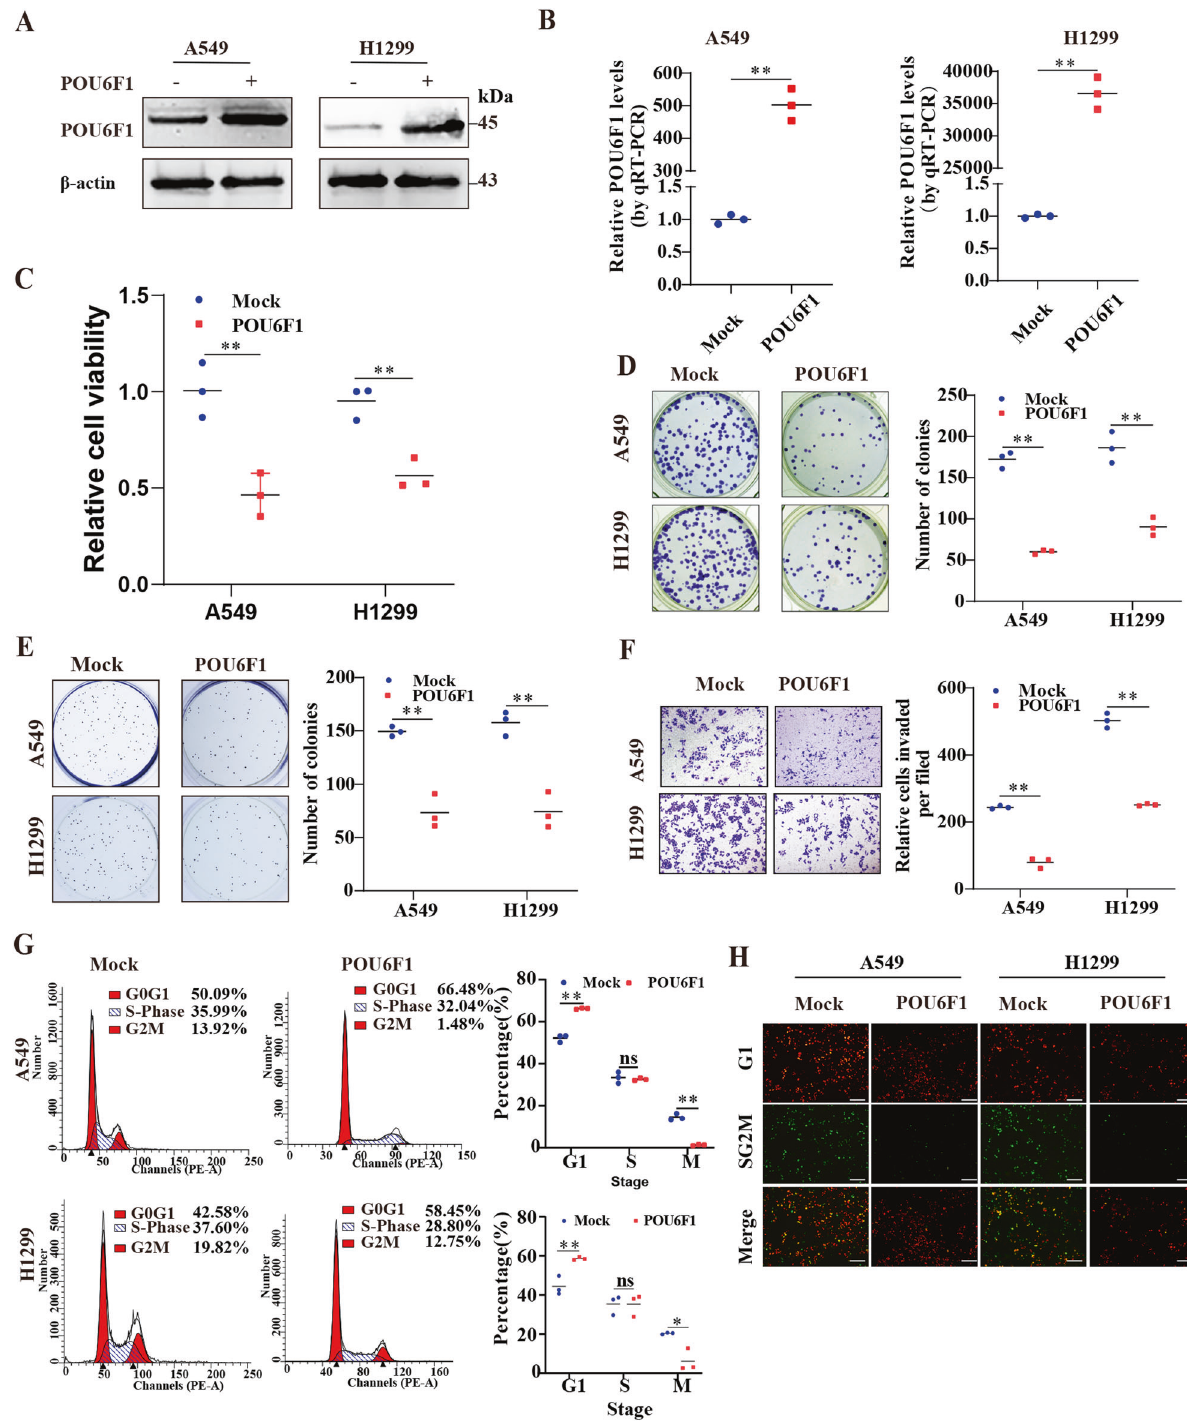
Fig. 3 POU6F1 represses the growth and aggressiveness of LUAD cells in vitro. A , B Western blotting and real-time qRT-PCR assays revealing the POU6F1 expression in A549 and NCI-H1299 cells stably transfected with empty vector (mock) or POU6F1. C , D CCK8 and colony formation assays indicating cell viability of A549 and NCI-H1299 cells stably transfected with mock or POU6F1. E , F Representative images (left panel) and quanti fi cation (right panel) of soft agar and transwell assays revealing the migration ability of A549 and NCI-H1299 cells stably transfected with mock or POU6F1. G Cell cycle detection in A549 and NCI-H1299 cells transfected with empty vector (pCMV-HA) or pCMV-HA- POU6F1. H Immuno fl uorescence revealing cycle change of A549 and NCI-H1299 cells transfected with pCMV-HA or pCMV-HA-POU6F1, and those co-transfected with pRetroX-G1-Red and pRetroX-SG2M-Cyan vector. Scale bar: 100 μ m. The student ’ s t -test compared the difference in B – G . * P < 0.05, ** P < 0.01.